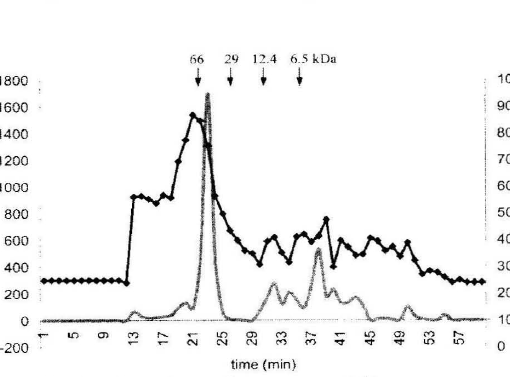
Figure 4. Fractionation of S. aureus 652 supernatant by gelfiltration using a Superose 12 column (Pharmacia, Uppsala, Sweden) and a Hewlett Packard (Vienna, Austria) TI-1050 high pressure liquid chronutography (HPLC) system. Neopterin formation in THP-l cells grmvn in RPMl/FCS was induced by the fractions and the costimuius IfN-y (250 U/m.!). Neopterin was assessed after 38 h bv ELISA (Brahms). E. coli 055:B5 LPS added in a concentration of 1 /-lg/ml served as positive control, inducing neoptcrin amounts of 174±O.3 I1mol/l (mean of two parallel wells ±